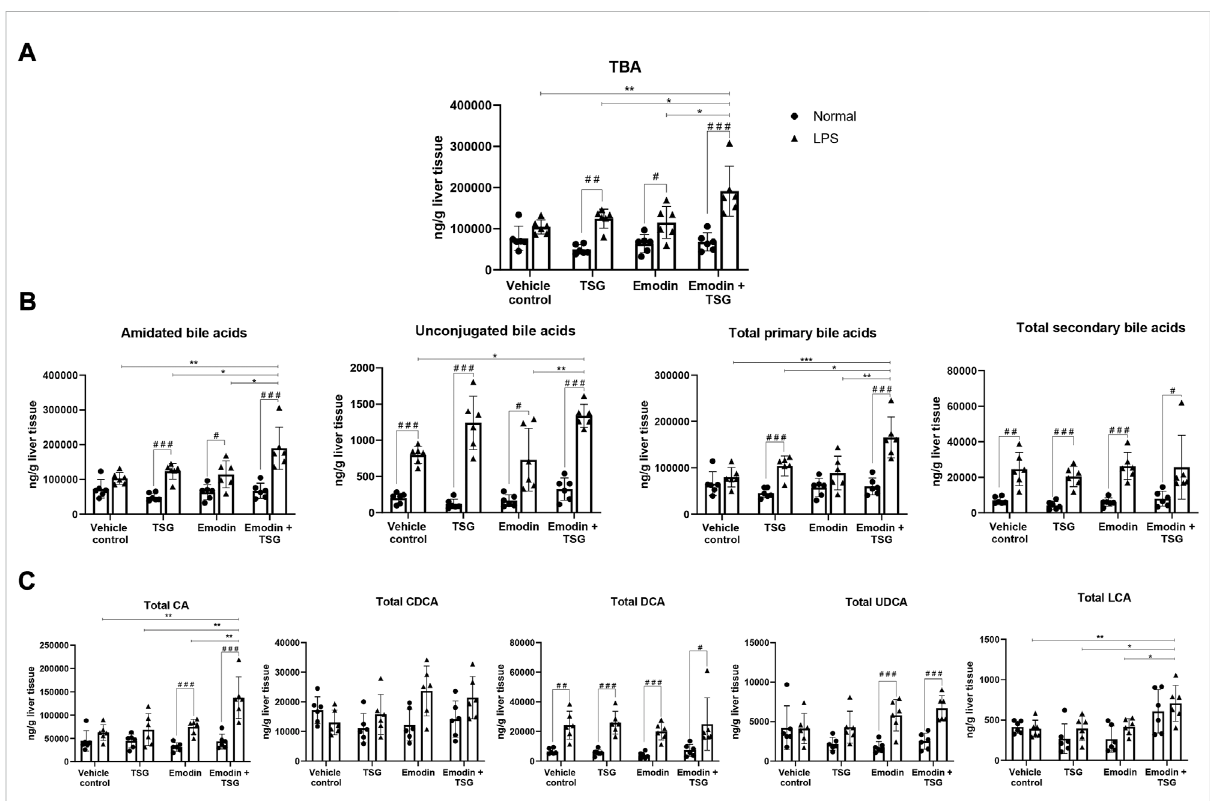
FIGURE 5 Hepatic concentrations of TBA (A) , amidated bile acids, unconjugated bile acids, total primary bile acids, and total secondary bile acids (B) and total CA, total CDCA, total DCA, total UDCA, and total LCA (C) after oral administration of vehicle control, TSG, emodin or their combination to normal and LPS-mediated in fl ammatory stress model rats. The data are expressed as mean ± SD ( n = 6). # p < 0.05, # # p < 0.01, # # # p < 0.001 by Student ’ s t-test, * p < 0.05, ** p < 0.01, *** p < 0.001 by two-way ANOVA followed by the Tukey post hoc